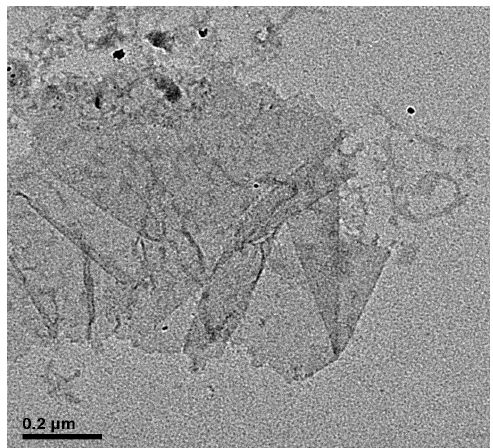
Figure 1. TEM image of a GO flake. Recorded with a JEOL-200FXII (JEOL, Tokyo, Japan) microscope working at 200 kV and with 0.28 nm point-to-point resolution (Electron Microscopy Sciences, ref CF-400CU).